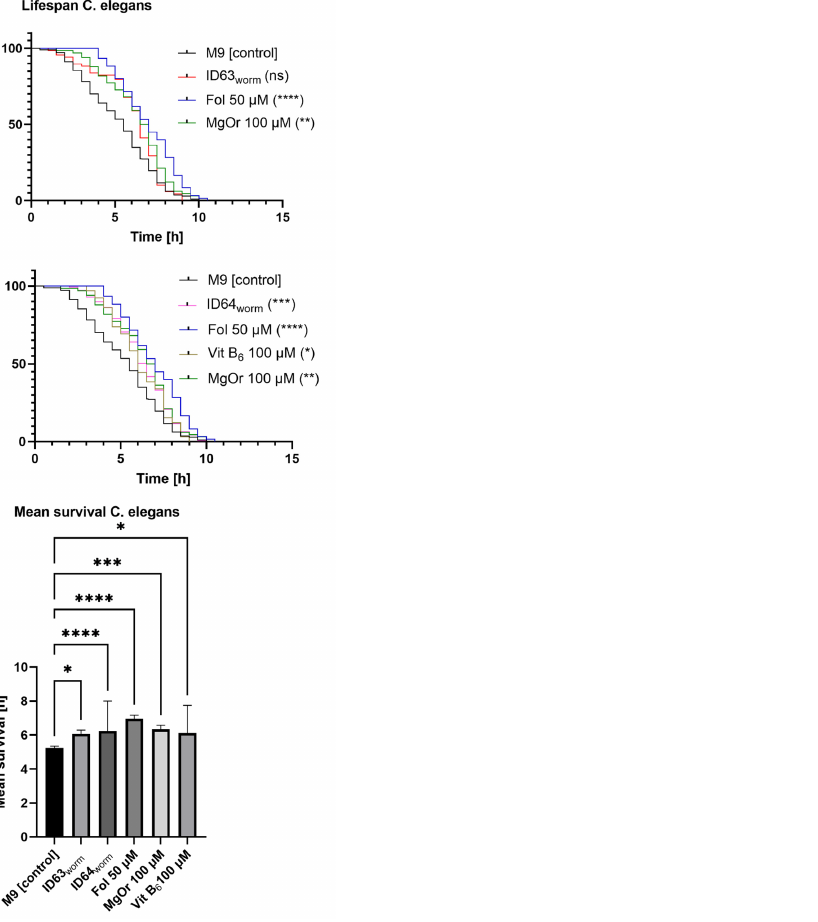
Figure 7. The lifespan under heat-stress of C. elegans after treatment with either ID63 worm , ID64 worm or their single substances in CL2006. ( A ) The single substances lead to an increase in heat-stress resistance of the nematodes although the combination of them does not have a significant impact. ( B ) After combination with vitamin B 6, the resulting treatment leads to a significant increase in heat- stress resistance. For heat-stress experiments, the survival was assessed according to the penetration of SYTOX Green nucleic acid stain into dead cells. N > 60. log-rank (MantelCox) test. ( C ) Mean Survival of C. elegans after treatment with either ID63 worm , ID64 worm or their single substances in CL2006. Significance was determined by one-way ANOVA. p * < 0.05, p ** < 0.01, p *** < 0.001 and p **** < 0.0001. ID63 worm = Fol 50 µ M and MgOr 100 µ M; ID64 worm Fol 50 µ M, MgOr 100 µ M and Vit B6 100 µ